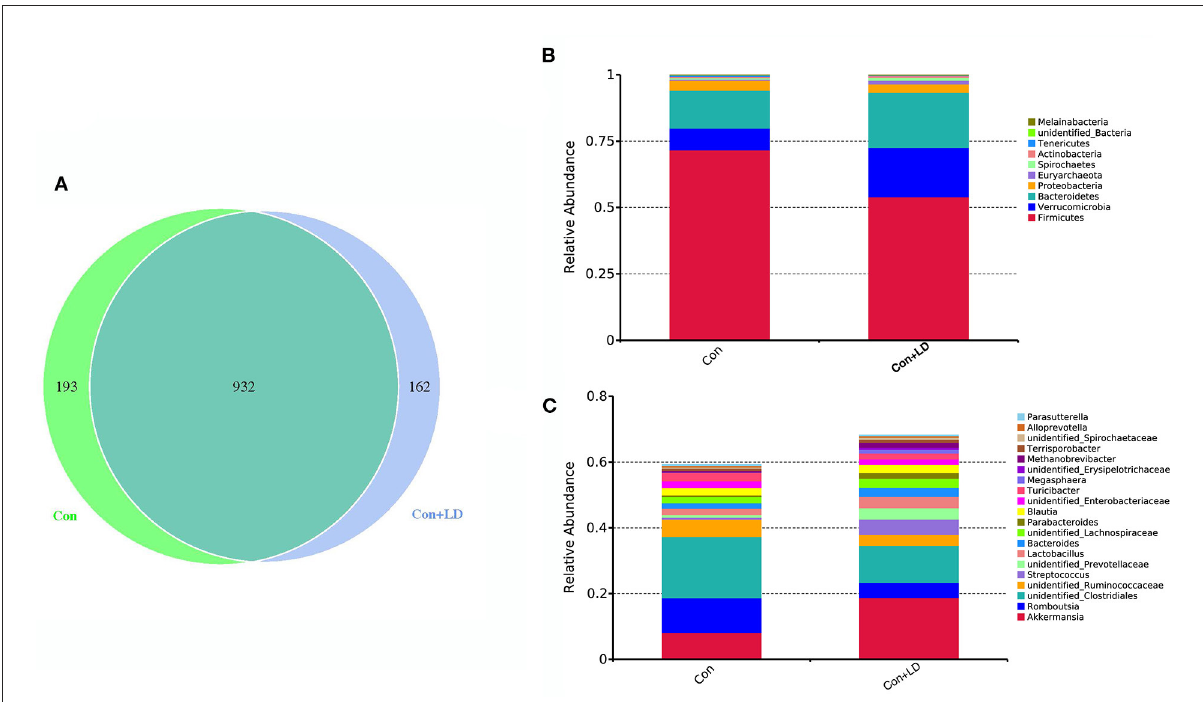
FIGURE2 Colonic bacterial composition of growing-finishing pigs. (A) Venn picture showed shared or unique OTUs between two groups. Abundant phyla (B) and genera (C) in the colonic microbiota. Con, basal diet; Con + LD, basal diet + 0.1 % L. delbrueckii .